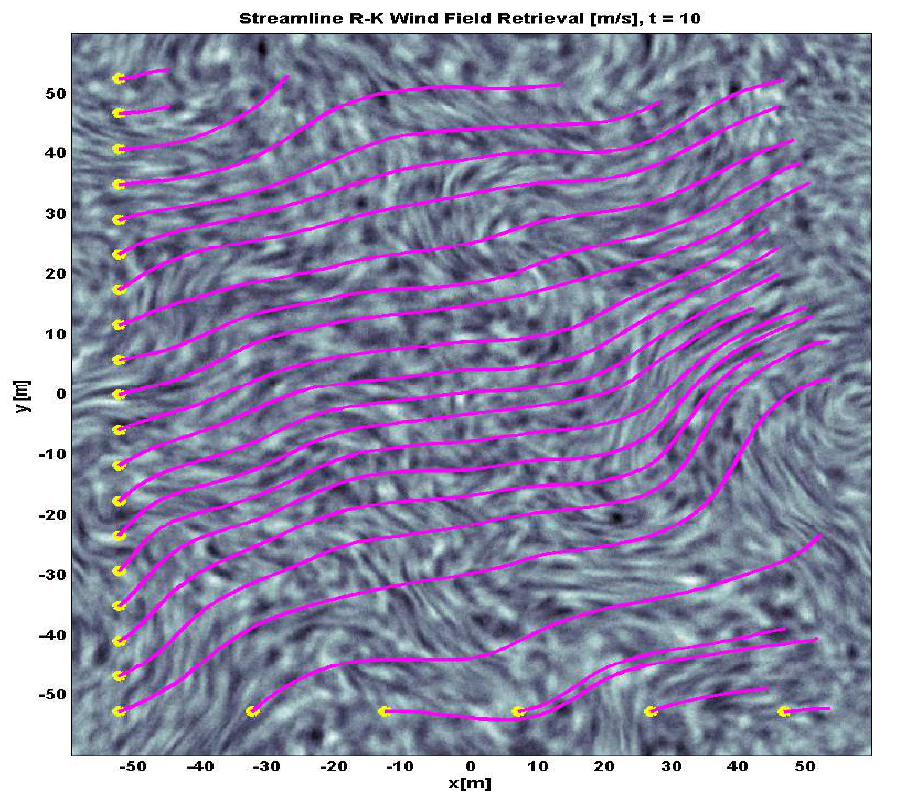
Figure 4. Runge–Kutta streamline example from stochastic model using 25 start points shown in yellow. Cubic interpolation is used to smooth the